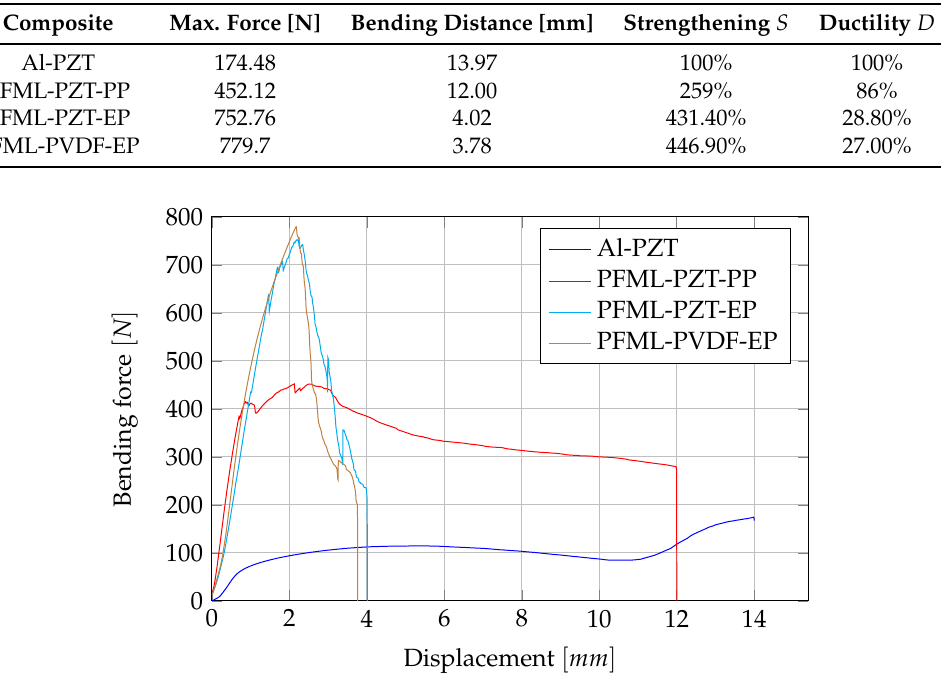
Figure 6. Comparison of the force–displacement curves from the static three-point bending